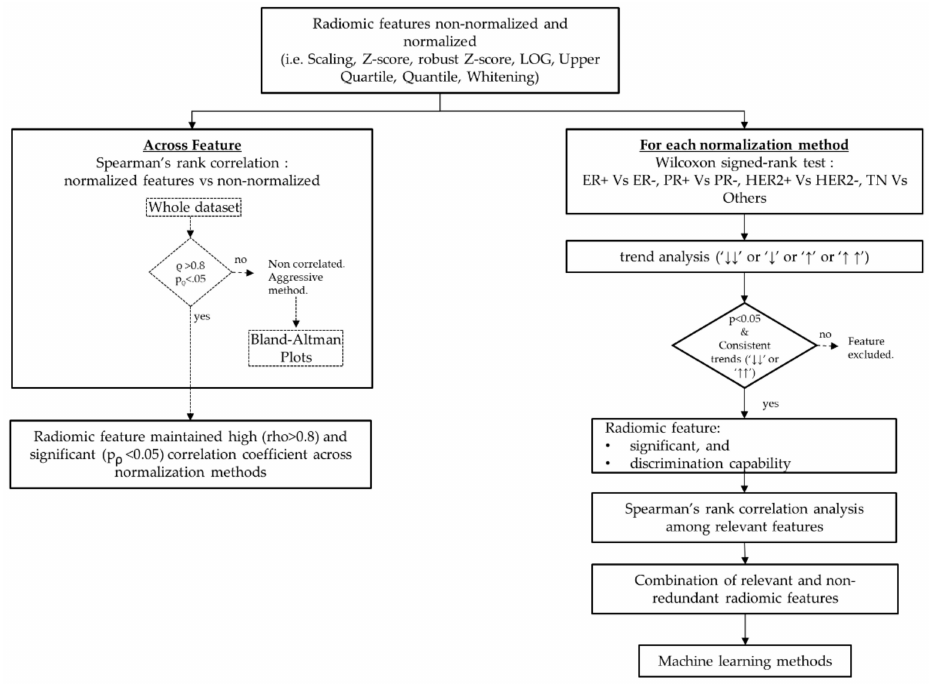
Figure 1. Radiomic analysis